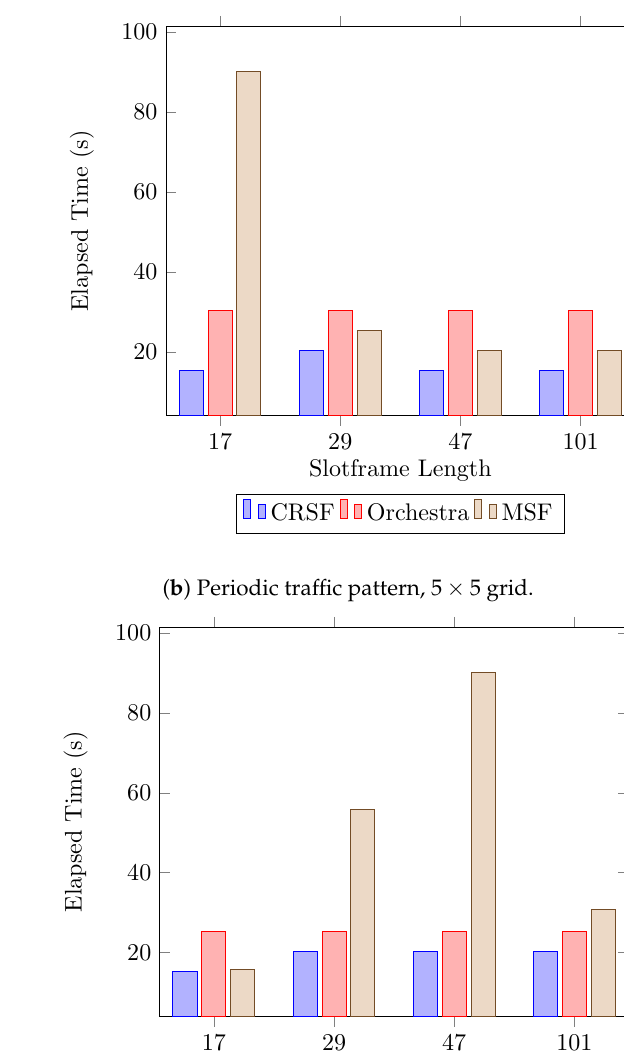
( a ) Periodic traffic pattern, 4 × 4 grid. ( b ) Periodic traffic pattern, 5 × 5 grid.